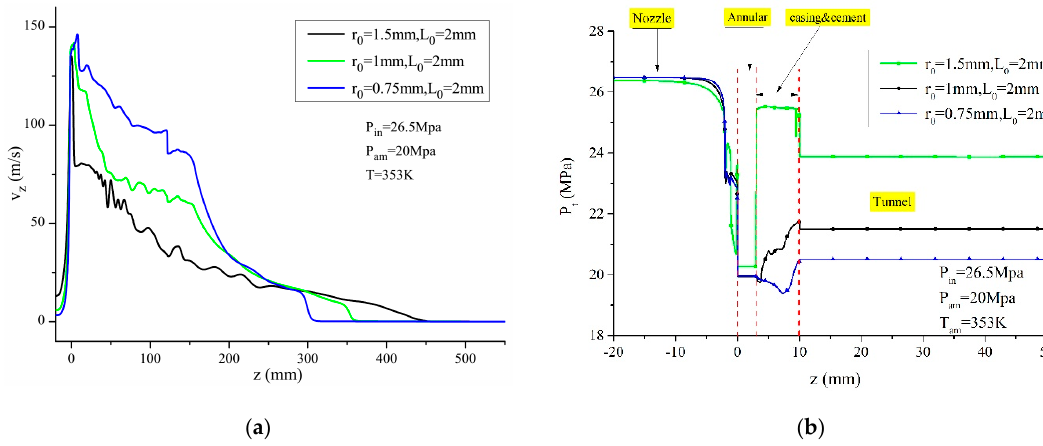
Figure 14. The effect of nozzle outlet radius on the distribution of total pressure axial velocity. ( a ) Axial velocity of jetting; ( b ) Total pressure on the perforation.